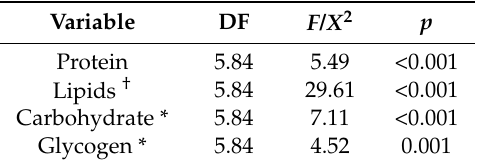
Figure 3. Mean ( ± s.e.m) relative quantity (mg/g) of soluble proteins ( A ) and median ( ± quartiles) lipids ( B ), from spectrophotometric assays of homogenized tissues of individual newly emerged honey bees, and those from pesticide treatment groups after two weeks. ( A ) White bar = Newly emerged bees; Black bar = Control treatment; Dark grey bars = Clothianidin Low (CLLO) and High (CLHI) dose treatments; Light grey bars = Imidacloprid Low (IMLO) and High (IMHI) dose treatments. Single point in ( B ) represents outlying data point. Letters above bars represent significant differences across treatments from Student’s ( A ) or multiple comparison Wilcoxon ( B ) post hoc tests. Table 2. Results from separate statistical tests of experimental treatments on energetic and nutrient substrate content of individual honey bees after two